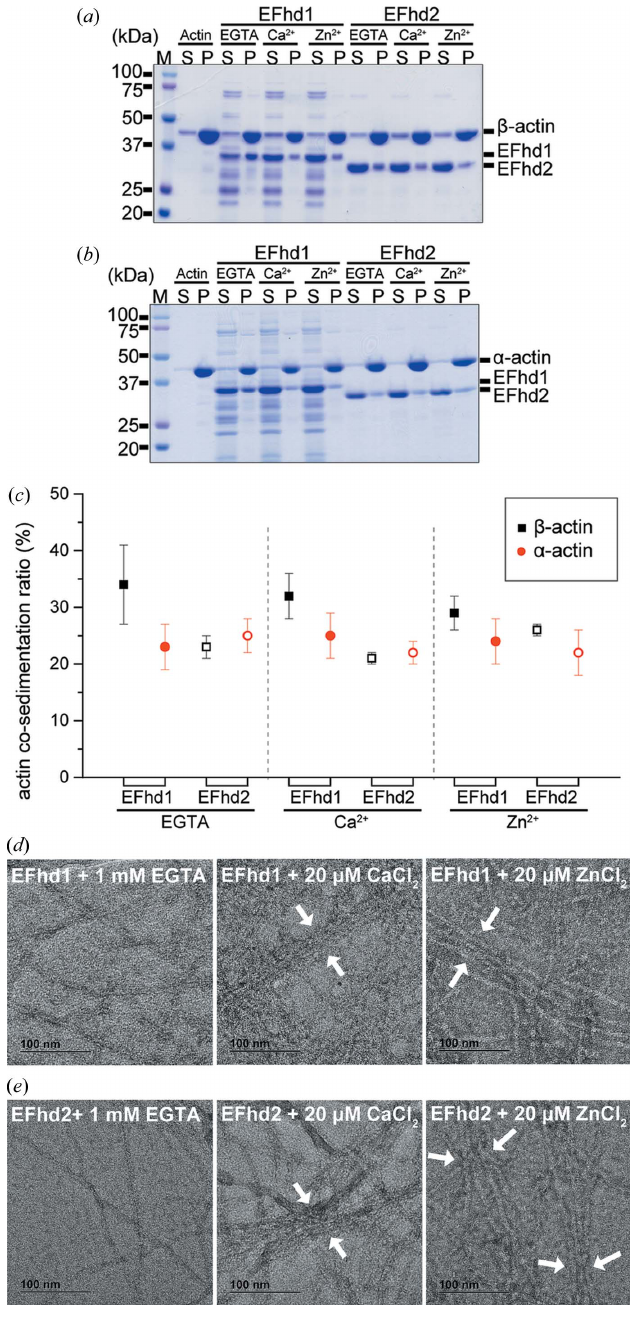
Figure 5 In vitro actin co-sedimentation assay (F-actin binding) and negative staining electron microscopy. SDS–PAGE analysis of in vitro actin co- sedimentation assays with EFhd1 and EFhd2. Protein samples (12 m M ) were added to polymerized ( a ) (cid:3) -actin (8 m M ) or ( b ) (cid:2) -actin (8 m M ) in the presence of 1 m M EGTA, 1 m M CaCl 2 or 20 m M ZnCl 2 . ( c ) Co- sedimentation ratios from each experiment. Filled and open black squares show the co-sedimentation ratios for EFhd1 and EFhd2 with (cid:3) - actin, respectively, while filled and open red spheres show the co- sedimentation ratios for EFhd1 and EFhd2 with (cid:2) -actin, respectively. Symbols and error bars represent the mean and 95% confidence interval for the mean, which were calculated from five independent experiments. Negatively stained electron micrographs: ( d ) F-actin assembled from (cid:3) - actin in the presence of EFhd1 and 1 m M EGTA, 20 m M CaCl 2 or ZnCl 2 ; ( e ) F-actin assembled from (cid:2) -actin in the presence of EFhd2 and 1 m M EGTA, 20 m M CaCl 2 or ZnCl 2